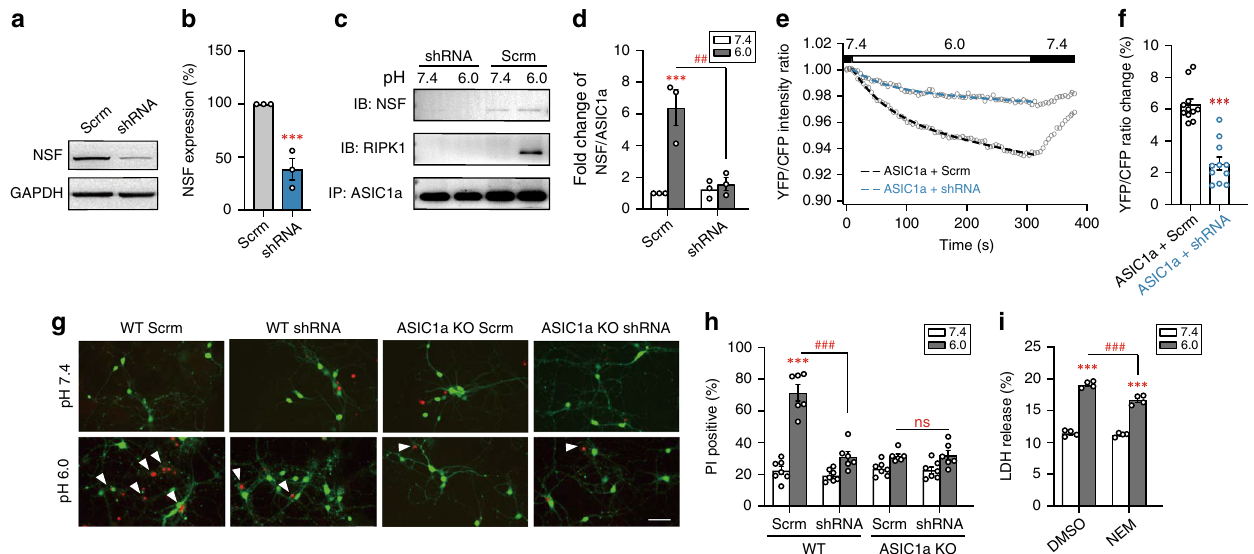
Fig. 5 NSF knockdown protects against acidotoxicity in cultured neurons. a , b Knockdown ef fi ciency of NSF shRNA in cultured neurons determined by western blotting. Shown are representative blots ( a ) and summary data ( b ). n = 3, *** p < 0.001 vs . Scrm (scrambled shRNA) by paired t test. c shRNA knockdown of NSF attenuated acid-induced associations of ASIC1a with NSF and ASIC1a with RIPK1. d Summary data of NSF pulled down by the ASIC1a antibody. The data are normalized to NSF/ASIC1a of neurons treated with Scrm at pH 7.4. n = 3, *** p < 0.05 vs . corresponding pH 7.4, ## p < 0.01 vs . Scrm in pH 6.0, by ANOVA. e NSF knockdown attenuated acid-induced decrease of CFP-ASIC1a-YFP FRET. Similar to Fig. 2b, but the cells were transfected with Scrm or NSF shRNA as indicated. n = 11 cells for each. f Summary of ratio changes at 5 min of the pH 6.0 treatment for data in ( e ). *** p < 0.001 vs . CFP-ASIC1a-YFP with Scrm by unpaired t test. g PI staining of cultured cortical neurons prepared from WT and ASIC1a KO mice transfected with NSF- shRNA or Scrm shRNA. Scale bar, 50 µ m. The neurons were treated at either pH 7.4 or pH 6.0 for 1 h and then returned to the normal culture medium for 24 h before PI staining. Knocking down NSF reduced acid-induced neuronal death in WT, but not ASIC1a KO, neurons. h Summary data for ( g ). n > 200 neurons counted for each. *** p < 0.001 vs . corresponding pH 7.4, ns, no statistical signi fi cance, ### p < 0.001 vs . Scrm in pH 6.0, by ANOVA. i